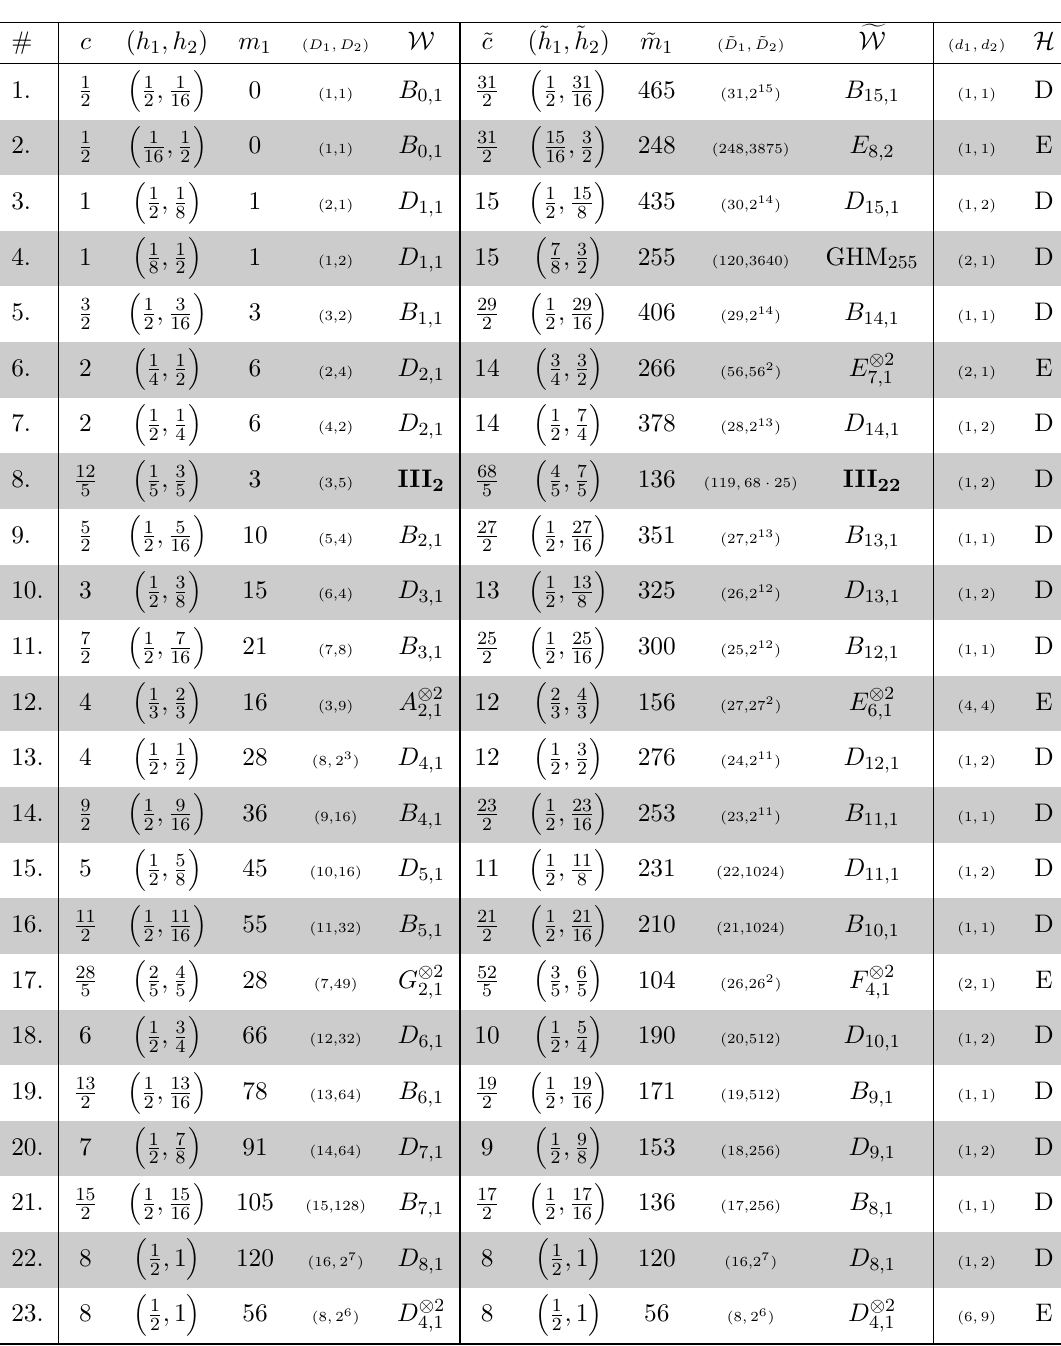
Table 5. CFT pairings, c H = 16 with ( n 1 , n 2 ) = (1 , 2) . The meromorphic theory H in the last column is E , denoted E, or E [ D ] , denoted 8 , 1 ⊗ E 8 , 1 1 16 , 1